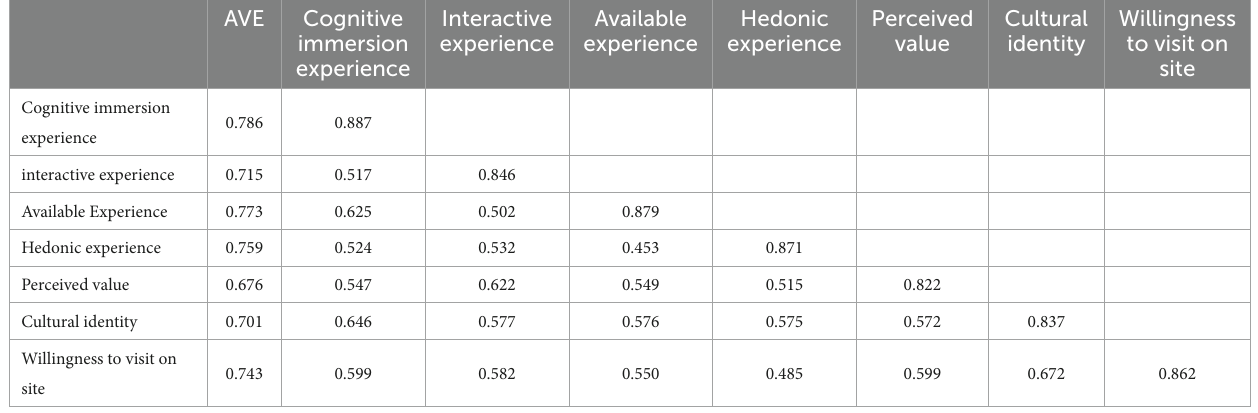
TABLE 3 Distinct validity.